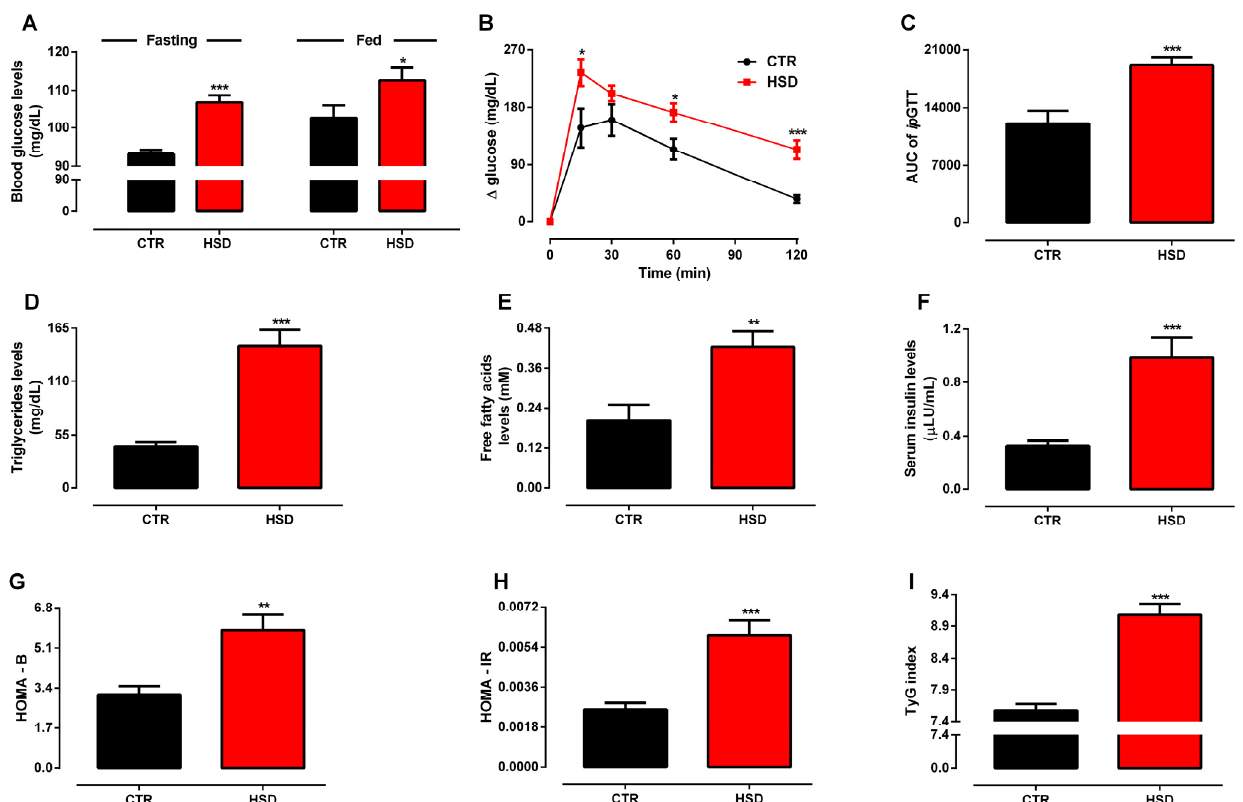
Figure 2. Glucose–insulin axis function assessment. ( A ) Fasting and fed blood glucose levels (mg/dL), ( B ) blood glucose levels (mg/dL) during an intraperitoneal glucose tolerance test (ipGTT), ( C ) AUC of ipGTT, ( D ) serum triglyceride levels (mg/dL), ( E ) serum free fatty acids (mM), ( F ) serum insulin levels ( µ LU/mL), ( G ) HOMA-B, ( H ) HOMA-IR, ( I ) TyG index assessed in rats fed a standard chow (CTR, n = 7) and a high-sucrose diet (HSD, n = 7) until 6 months from weaning. Points and bars represent the mean ± SEM (unpaired t -test one-tailed). * p < 0.05, ** p < 0.01, *** p <